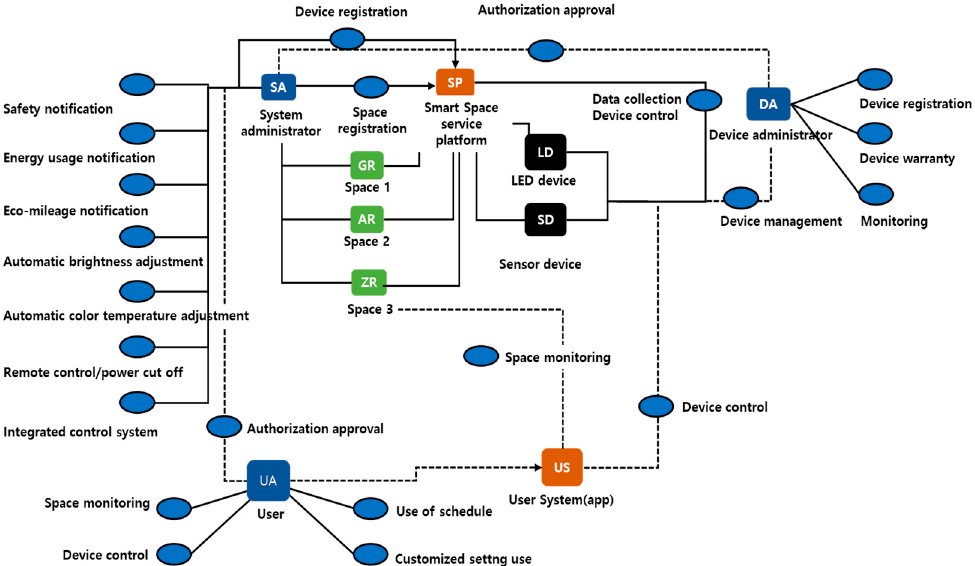
Figure 8. HCL Platform Use Case.